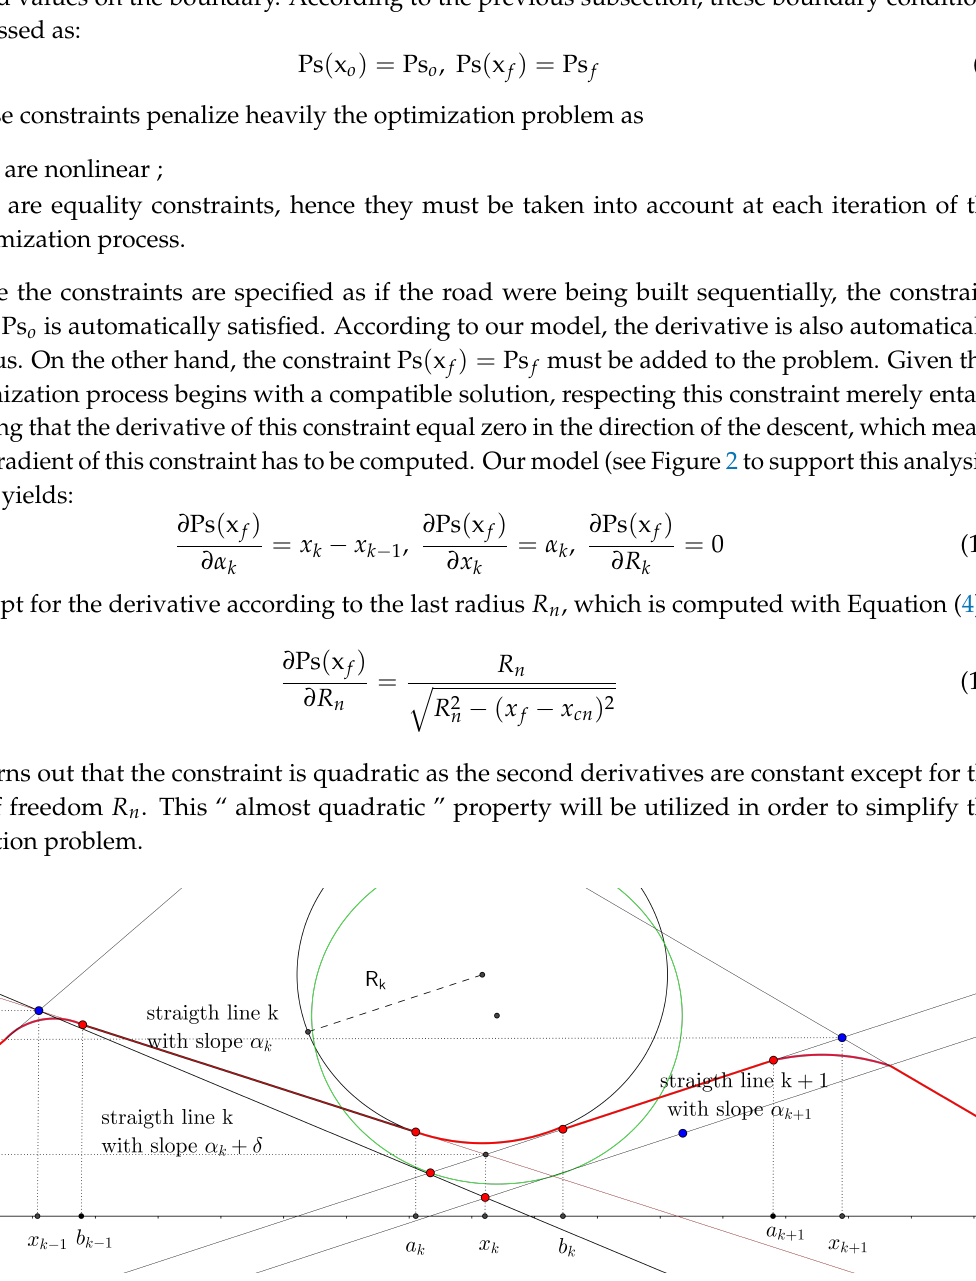
Figure 2. Longitudinal initial and modified profiles when one slope is